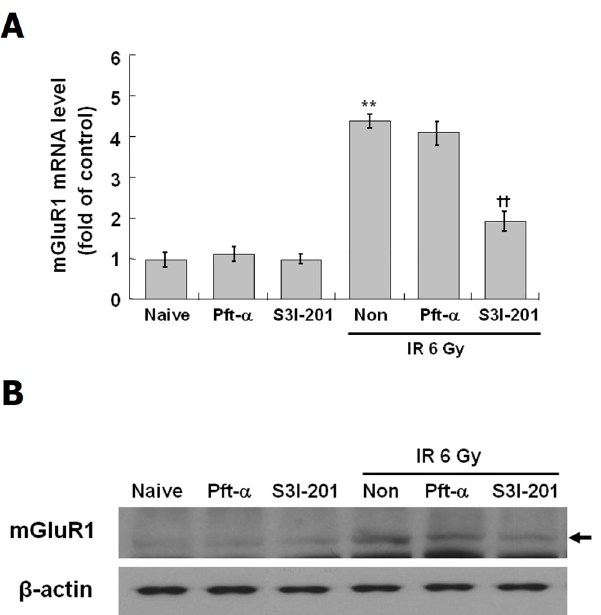
exposed to IR at 6 Gy and incubated at 37°C for 72 hr. Level of mGluR1 mRNA was analyzed by real-time PCR (A) and expression of mGluR1 was analyzed by Western blot (B). The results represent the mean ±